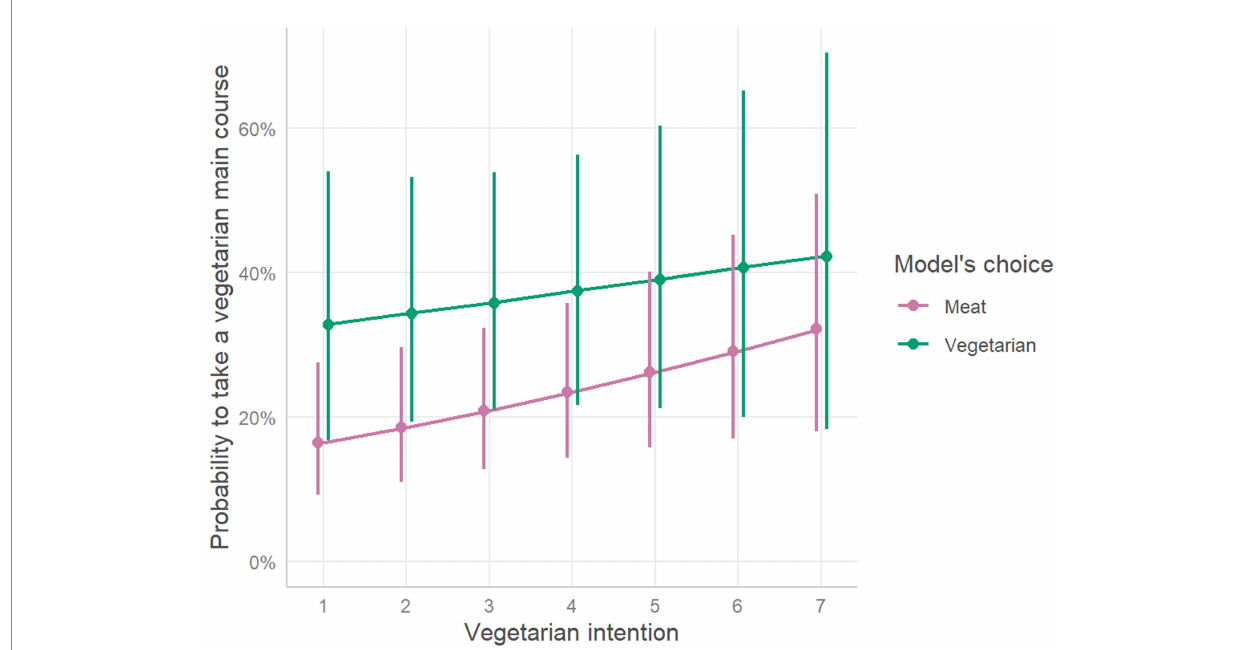
FIGURE 2 Probability to take a vegetarian main course, as function of vegetarian intention scores. The plot represents estimated effects of intentions on the probability to take a vegetarian main course for different model’s choices. Oblique lines represent the estimated marginal mean probability of taking a vegetarian main course, while the error bars represent 95% confidence intervals based on estimated standard errors (+/ − 1.96